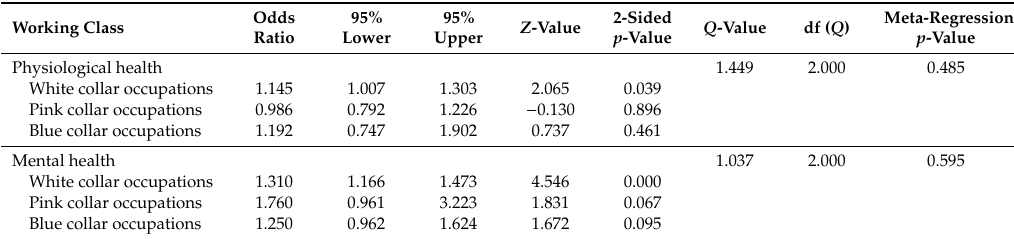
Table 4. Moderating e ff ect of working class on the association of long working hours with physiological when appropriate, for age, gender, educational level and